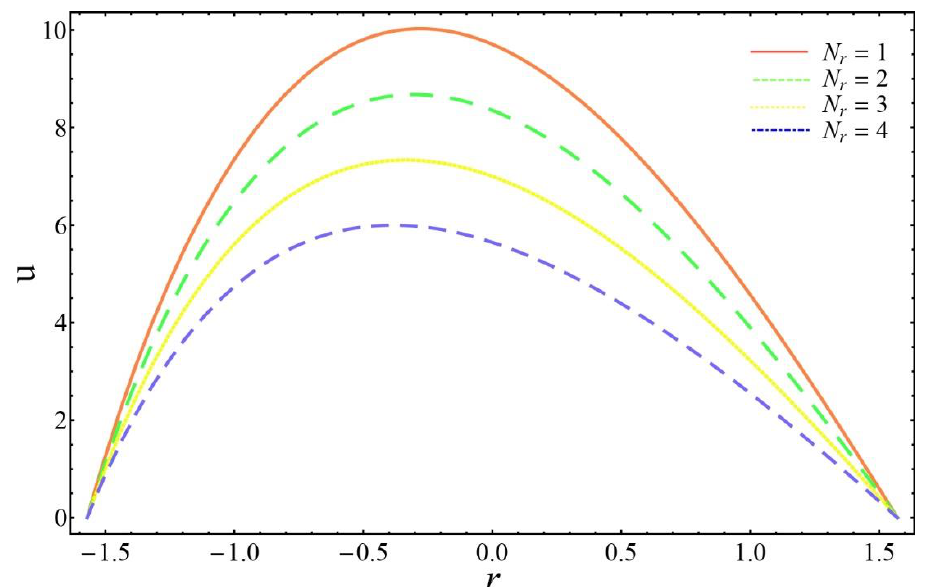
Figure 3. Alteration of 𝑁 𝑟1 on u when 𝑥 = 0.2; 𝑡 = 0; 𝑄 = 10; 𝛽 = 0.1; 𝜖 = 0.6; 𝑁 𝑐 = 2; 𝑘 = 2; 𝐸 1 = 0.1; 𝐸 2 = 0.1; 𝐸 3 = 0.9.